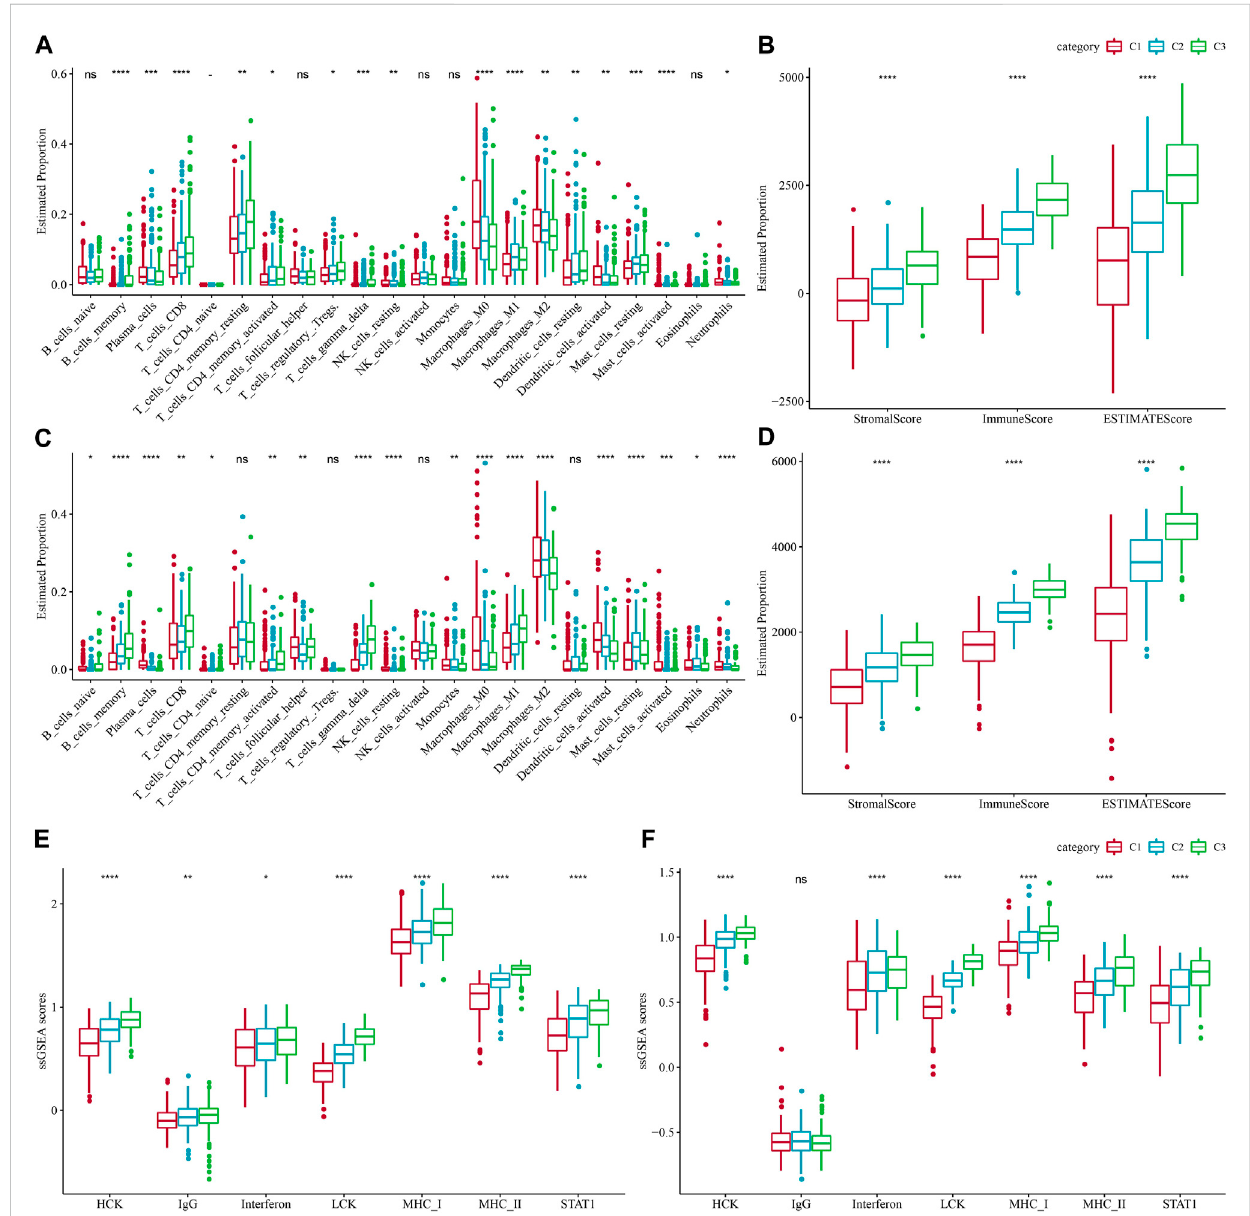
FIGURE 4 Proportions of immune cell components in the two lung adenocarcinoma cohorts. (A) Differences in 22 immune cell scores between different molecularsubtypesintheTCGA-LUADcohort. (B) DifferencesinESTIMATEimmunein fi ltrationbetweendifferentmolecularsubtypesintheTCGA-LUAD cohort. (C) Differences in the GSE72094 cohort 22 immune cell scores between different molecular subtypes. (D) Differences in ESTIMATE immune in fi ltration between different molecularsubtypes in theGSE72094 cohort. (E) Differences in seven in fl ammation-related gene cluster scores across molecular subtypes in TCGA-LUAD cohort. (F) Differences in gene cluster scores between different molecular subtypes in seven in fl ammatory-related genes in GSE72094